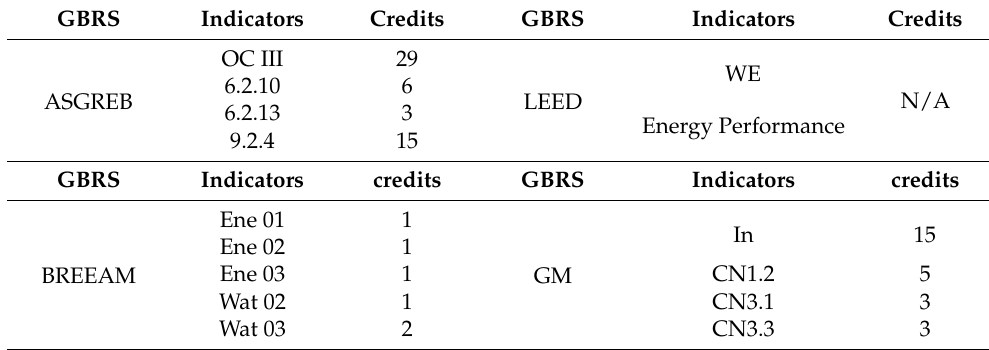
Table 10. Management scope CO 2 -related indicators analysis.